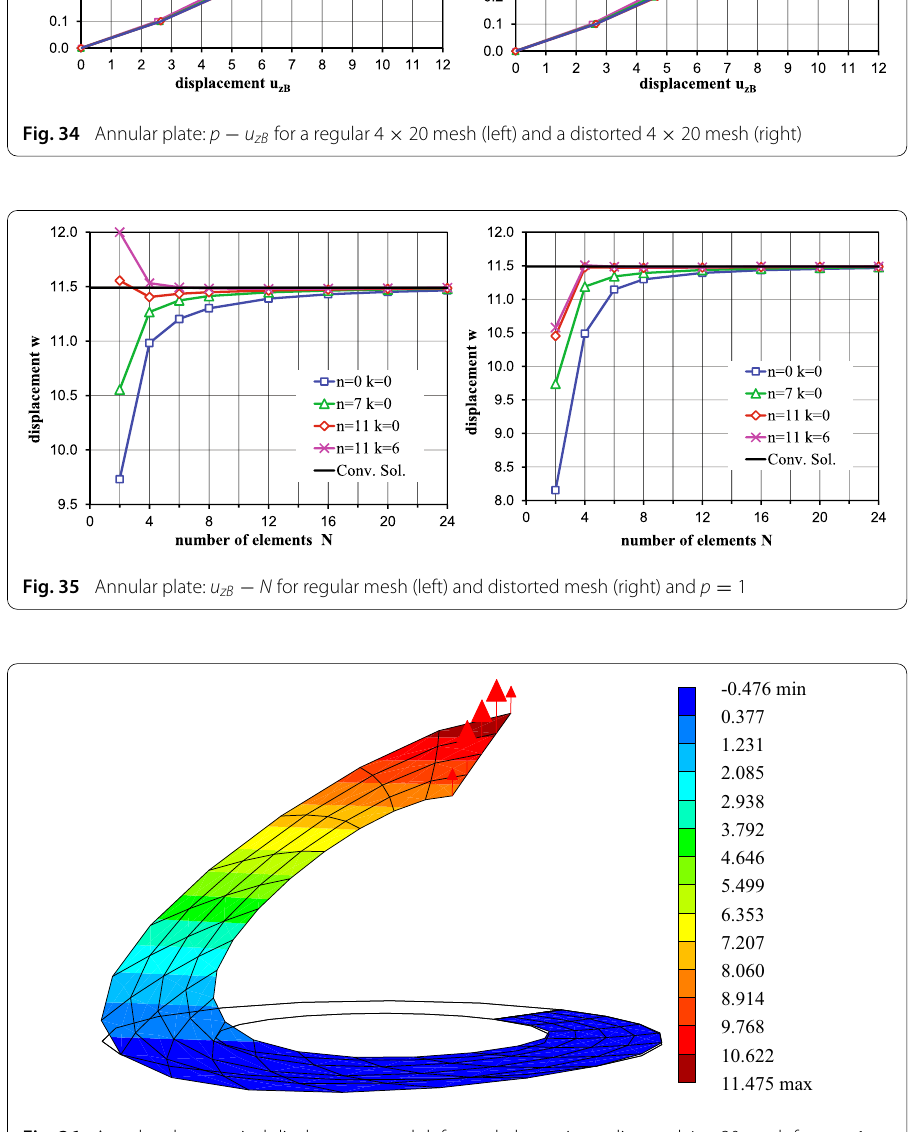
The convergence behavior of displacement u zB versus the number of elements N in width direction is presented in Fig. 35 for p = 1. One can see that the matrix M b